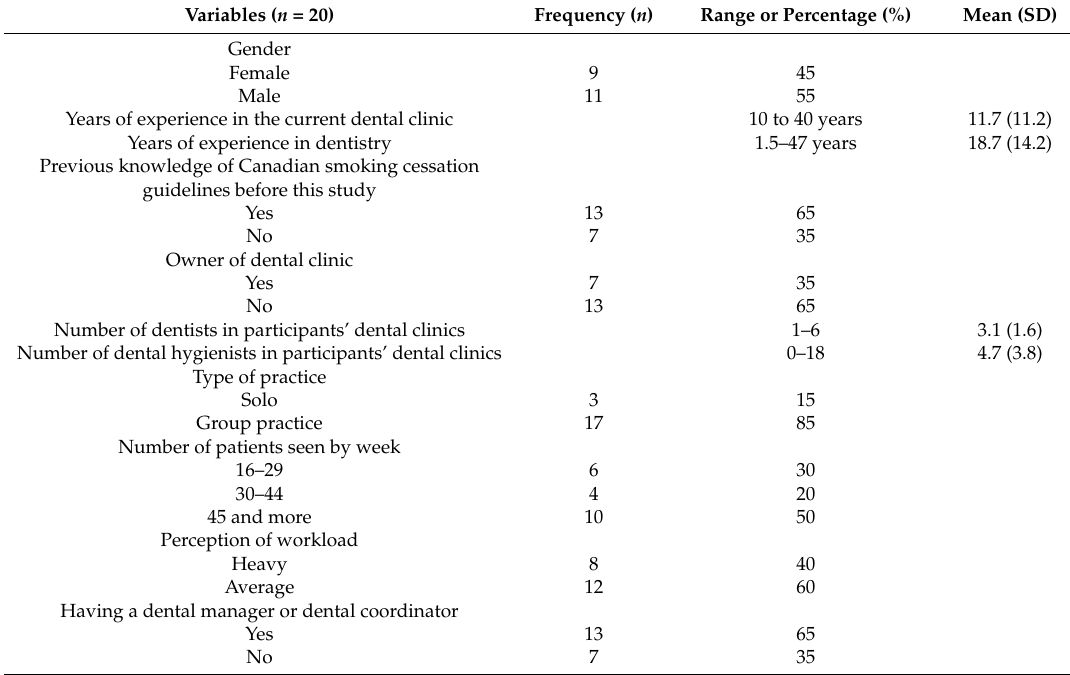
Table 1. Participants’